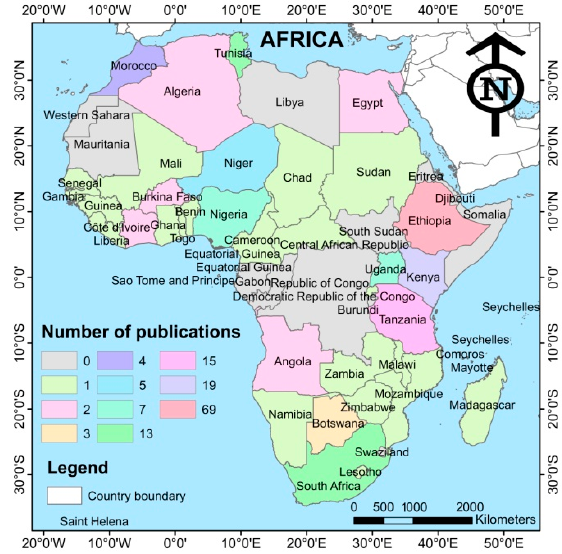
Figure 2. Relative distribution of reviewed papers by countries in Africa.